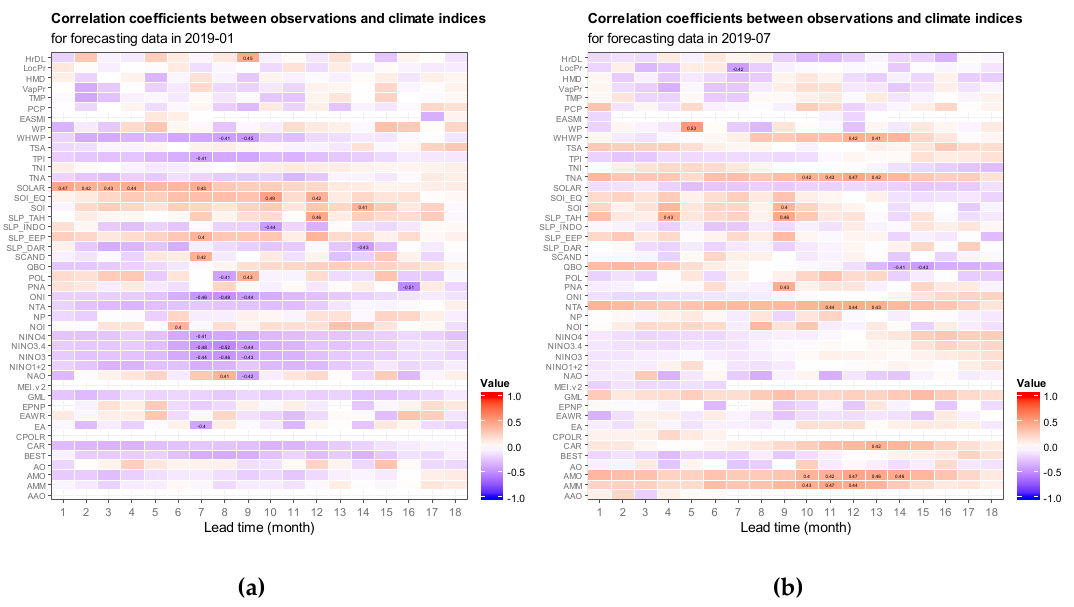
Figure 3. Results of the correlation analysis with predictors for forecasting the precipitation of ( a ) January and ( b ) July 2019.